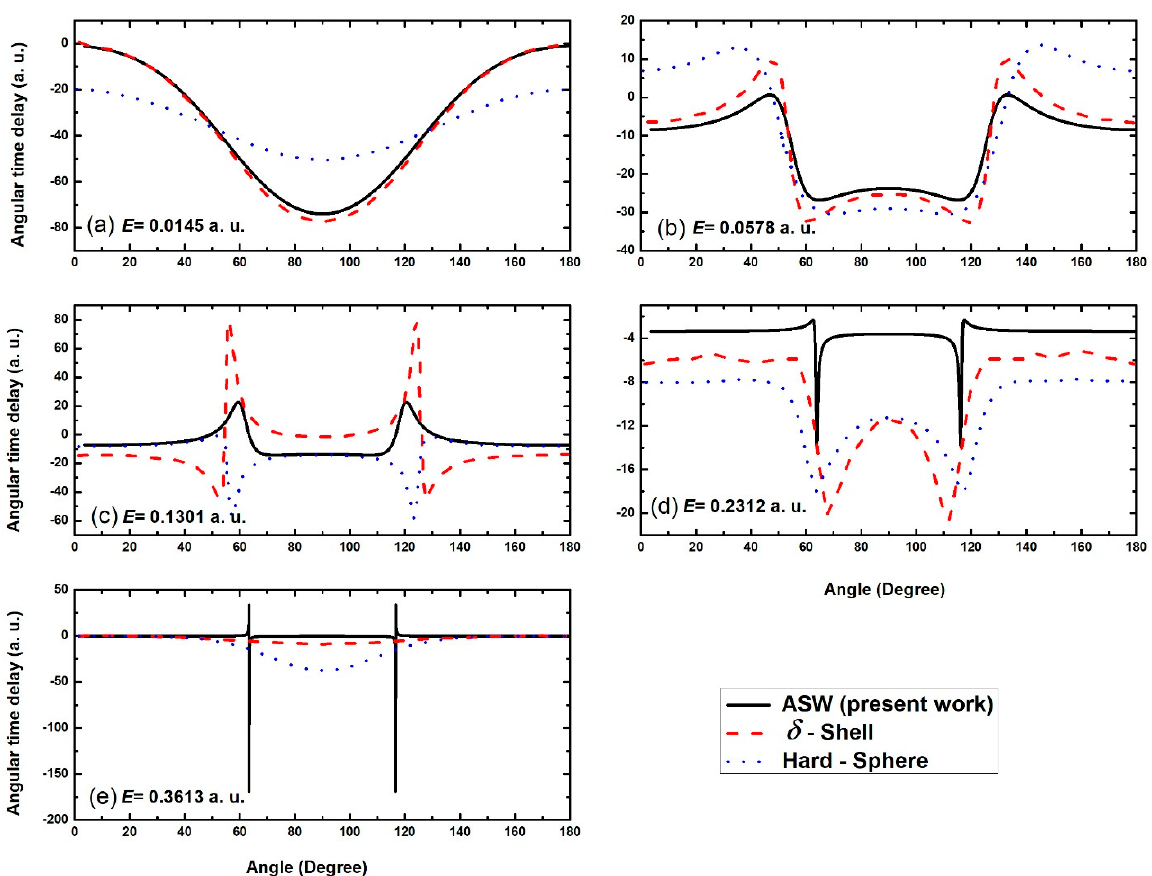
Figure 5. Comparison of angular time delay plotted for partial wave combination (cid:96) = 0,2 us- ing ASW potential (solid black line), δ -shell (red dashed line), and hard sphere (blue dotted line) ( a ) E = 0.0145 a.u., ( b ) E = 0.0578 a.u., ( c ) E = 0.1301 a.u., ( d ) E = 0.2312 a.u. and ( e ) E = 0.3613 a.u. E r = 0.0091 a.u.